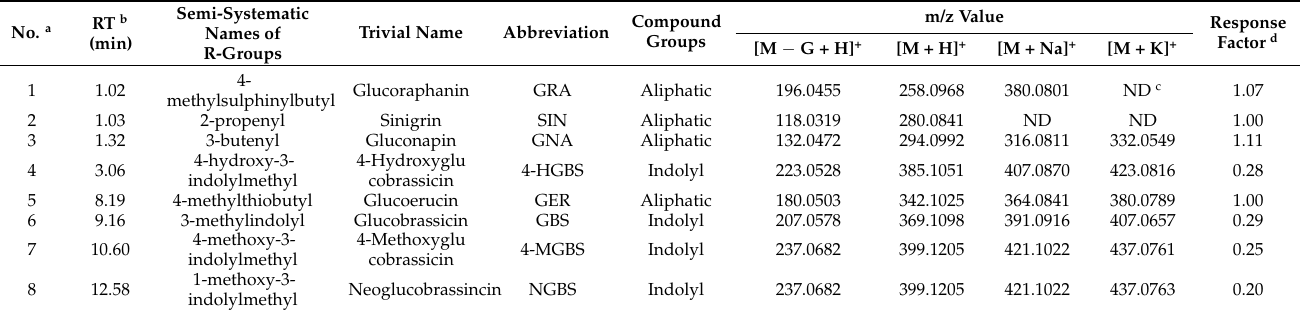
Table 3. Glucosinolates identified in sixteen different Chinese kale